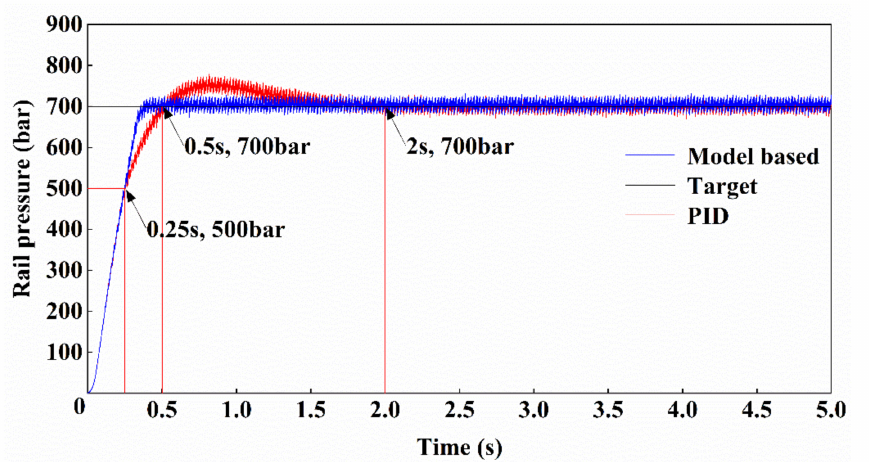
Figure 18. The 0–700 bar rail pressure